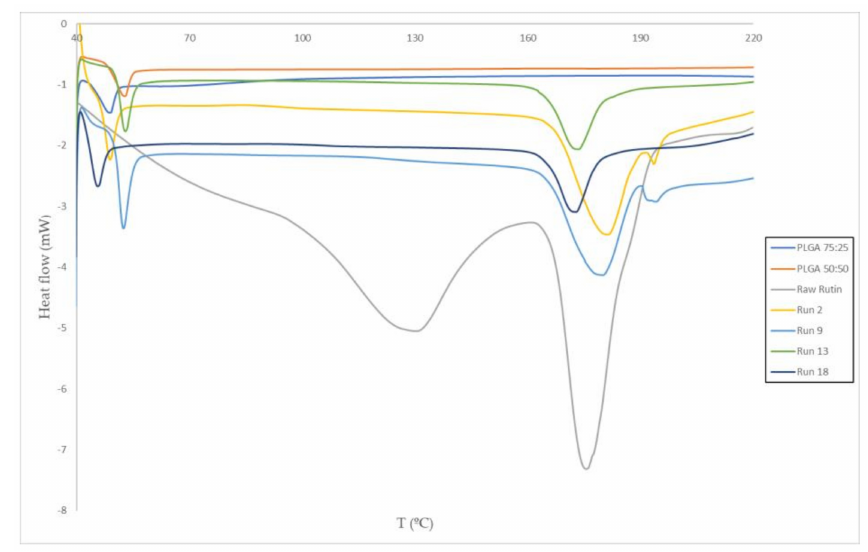
Figure 9. DSC tests of runs 2, 9, 13, 18, PLGA 50:50, PLGA 75:25, and raw